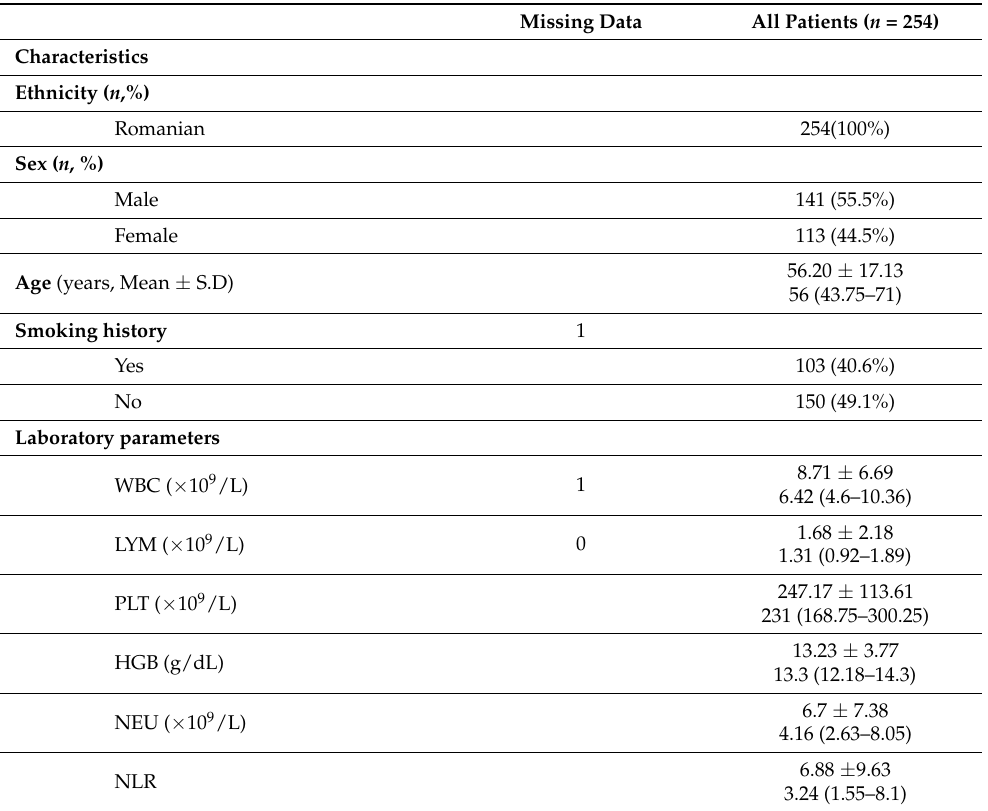
Table 1. Baseline demographic characteristics and clinical features on admission of the patients with